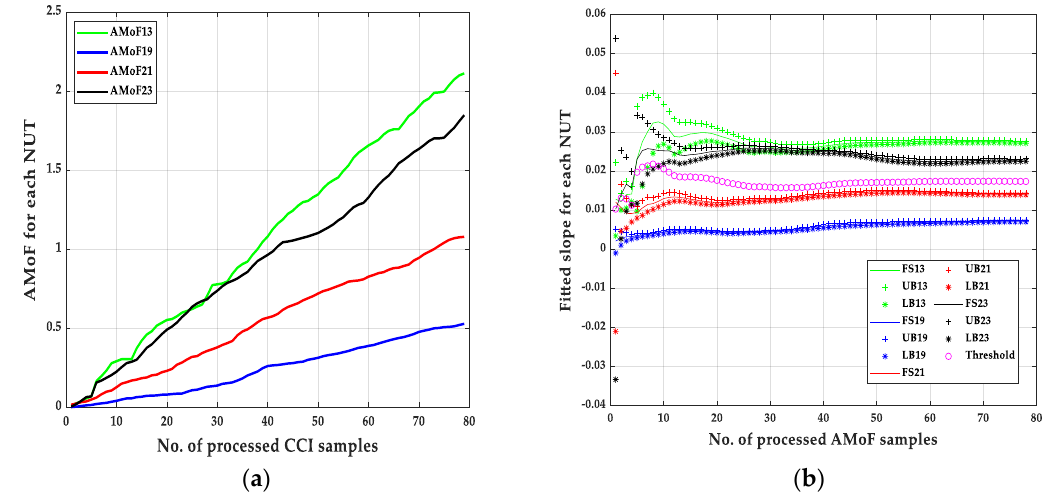
Figure 7. The AMoF and the fitted slope for different nodes for scenario NS1P3: ( a ) The AMoF for different NUT; ( b ) the fitted slope for NS1P3_FL_RWP 25/5. Table 7 Performance characterization for NS1P3_FL_RWP 25/5.